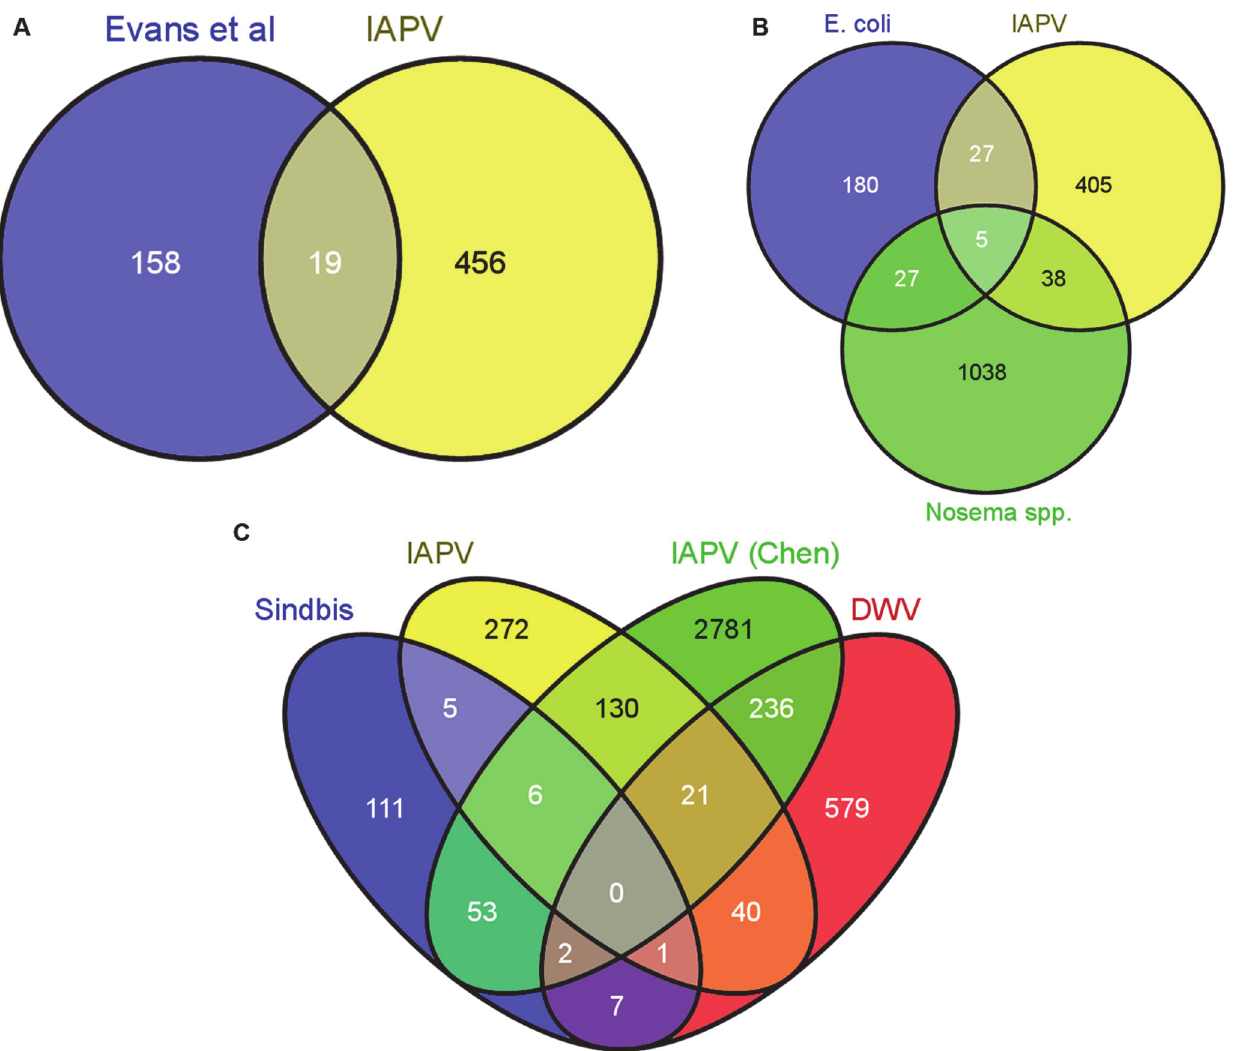
Fig 3. Comparative analysis of transcriptional responses to different immunostimulants. A) The 753 differentially expressed genes were compared to the set of canonical immune genes identified in the genome by Evans et al (2006). Only 19 genes were shared between these groups B) The differentially expressed genes were compared to genes differentially regulated in response to infection with E . coli and the microsporidian parasites Nosema apis and Nosema ceranae . There was little overlap among the groups, indicating that responses to acute viral infections utilize distinct pathways. C) Overlap with three previous studies examining transcriptional responses to Sindbis virus[24], IAPV[21] (from Chen et al, 2014), and DWV[27]. For all analyses, the Venn diagram was created using